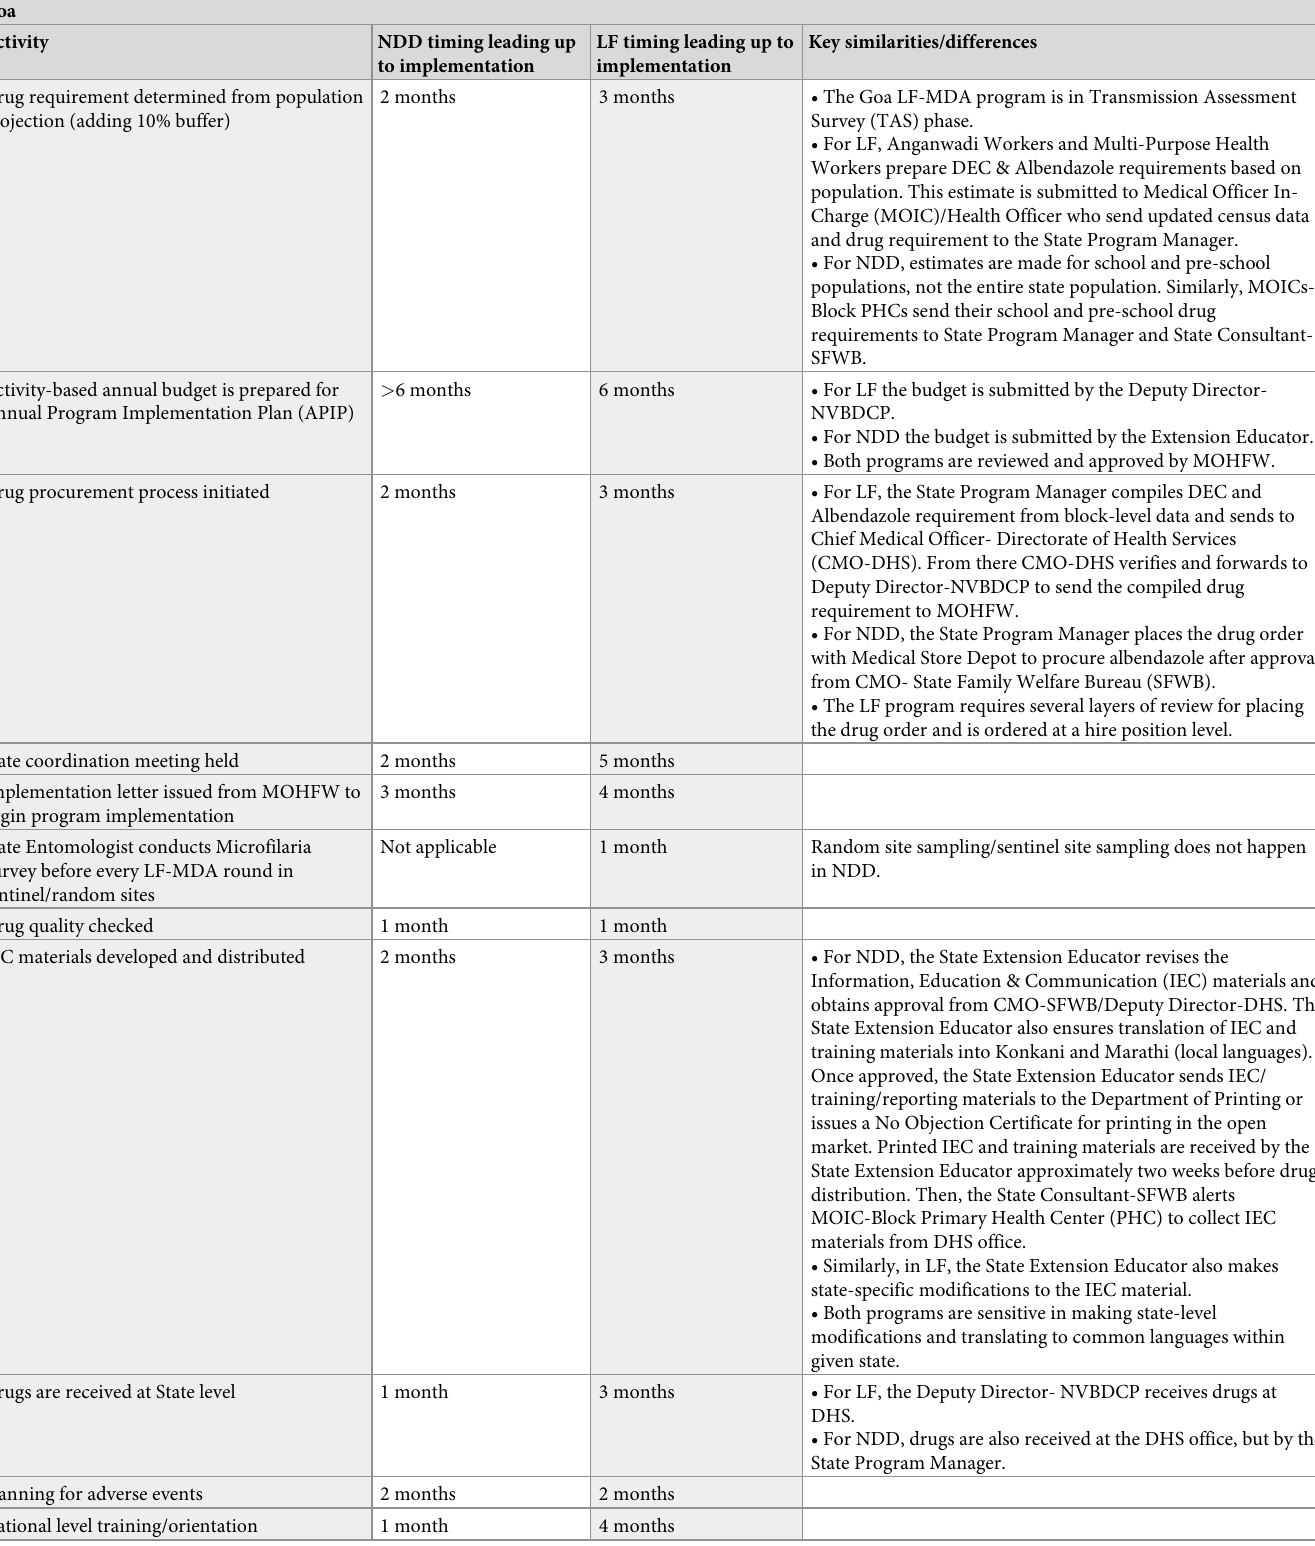
Table 2. Program mapping findings–Goa and